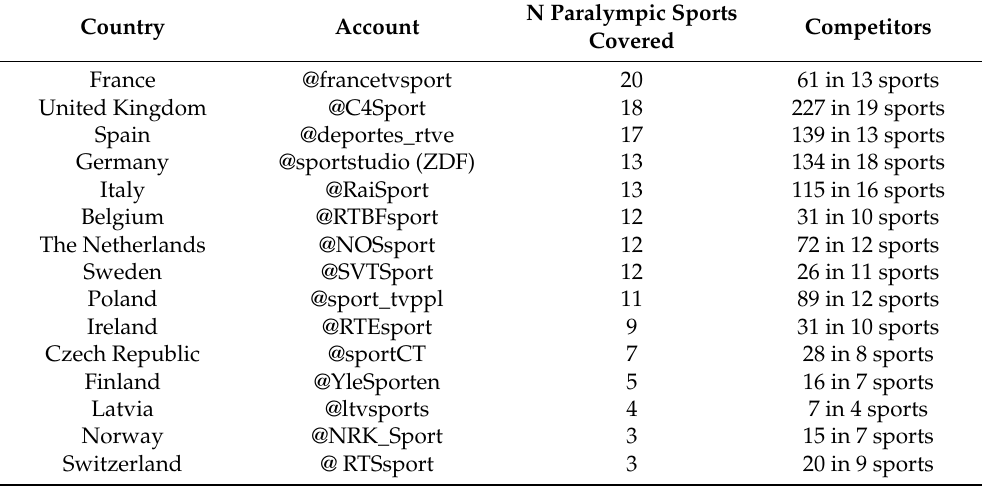
Table 5. Number of Paralympic sports covered by PSM companies and competitors in each country.